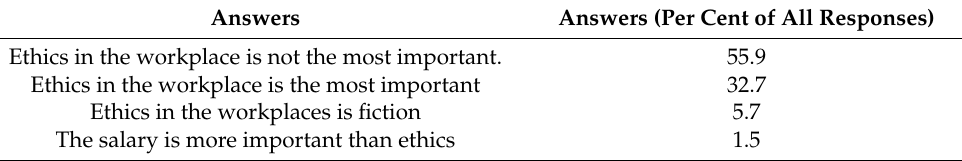
Table 4. Ethics in workplace.